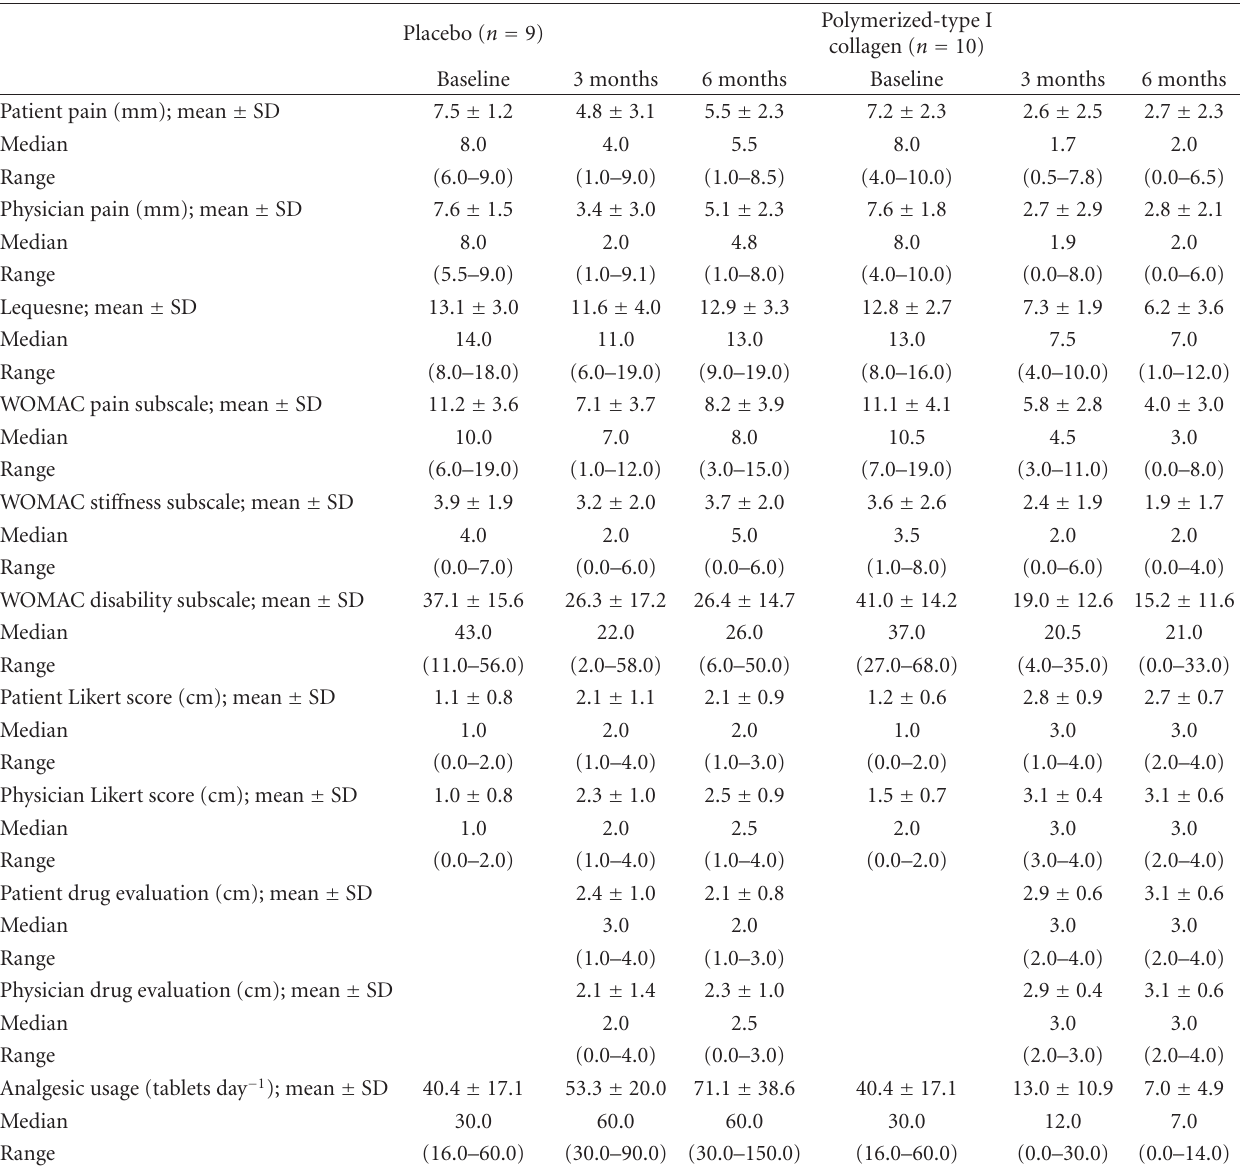
Table 2: Clinical characteristics of the